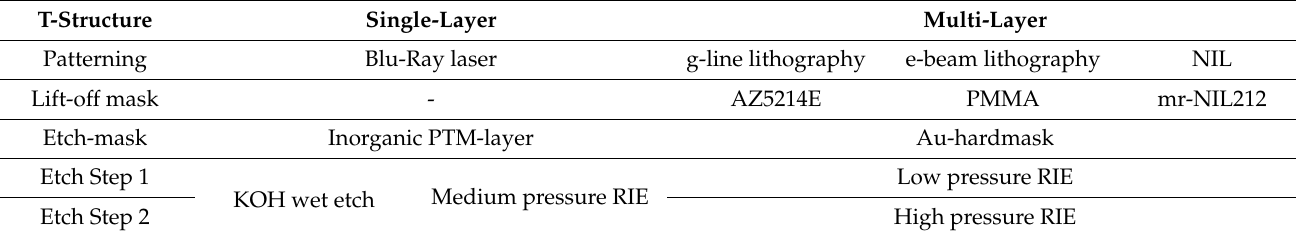
Table 1. Overview of five process sequences used to fabricate undercut T-structures